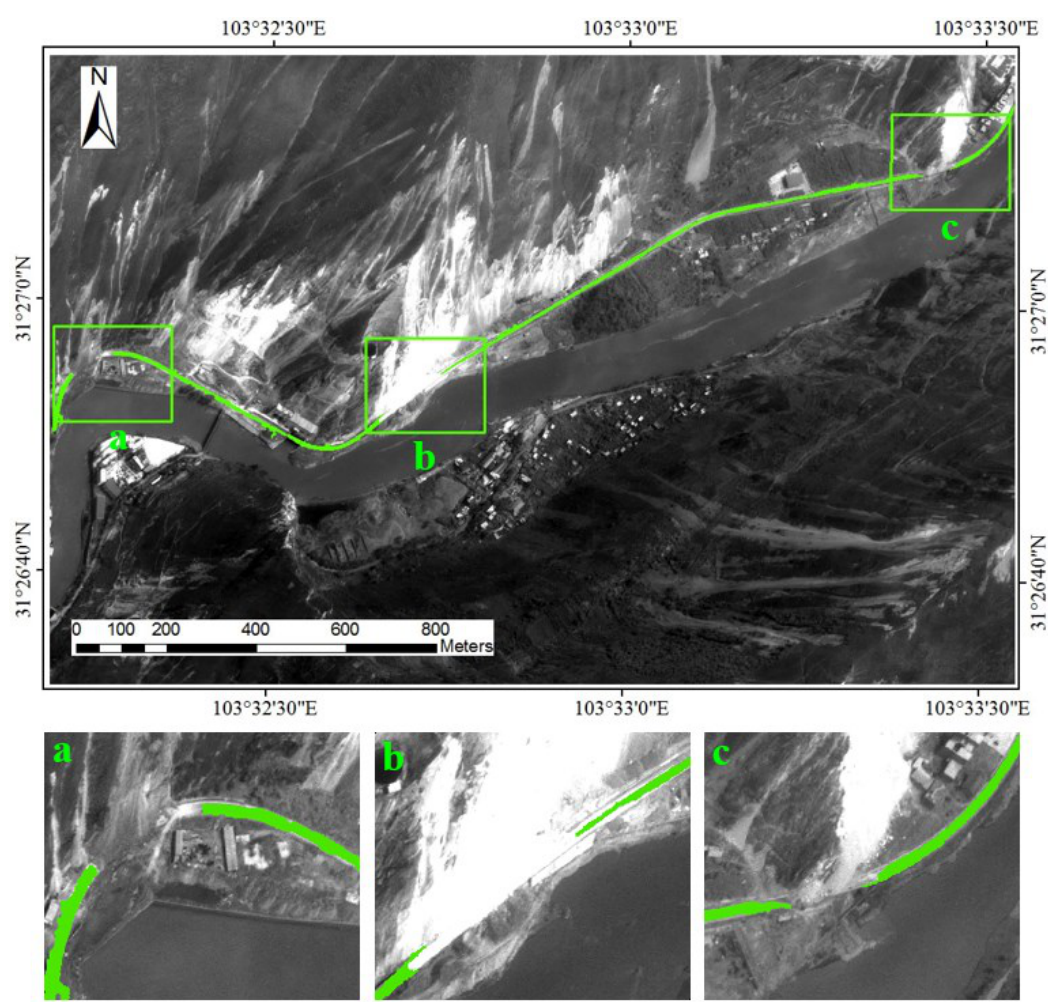
Figure 9. Results of post-disaster road extraction. Green regions are the post-disaster roads.